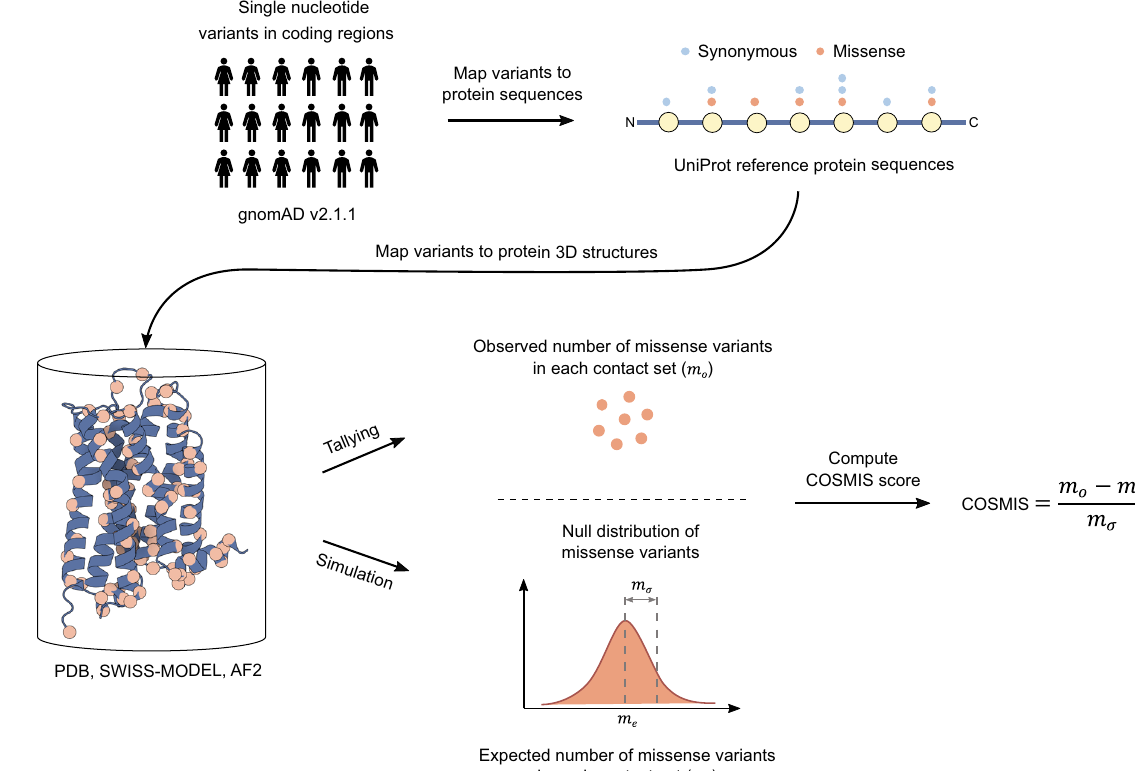
Fig. 1 Schematic of the COSMIS 3D mutational constraint quanti fi cation framework. The COSMIS framework consists of mapping single nucleotide variants (SNVs) from gnomAD to human reference protein sequences and protein 3D structures, the computation of 3D contact sets, tallying of unique missense variants observed in contact sets, and comparison of observed missense variant counts to a null distribution simulated based on a mutation- spectrum-aware statistical model. We quantify the constraint on the index amino acid site with the Z score of the observed missense variant count ( m o ) compared to the null distribution. gnomAD Genome Aggregation Database, PDB Protein Data Bank, AF2